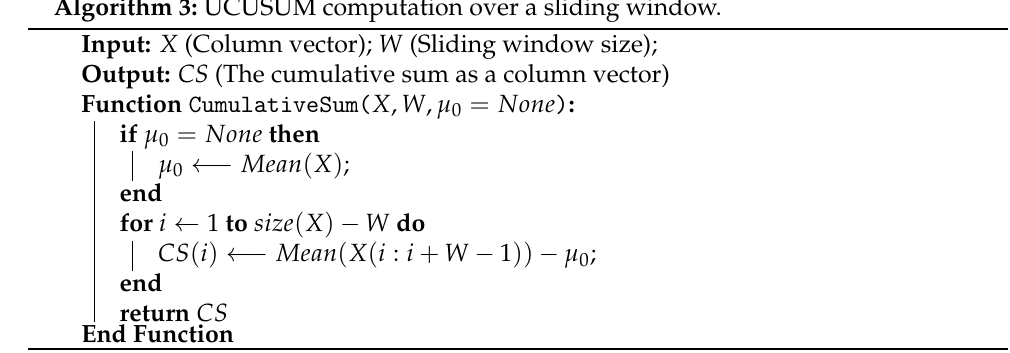
Algorithm 3: UCUSUM computation over a sliding